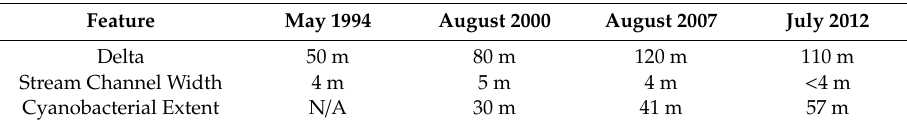
Table 2. Measured distance (m) of United States Geological Survey (USGS) aerial images, using Google Earth, for the Roberts Creek delta, approximate stream channel width, and extent of cyanobacterial growth into Tenmile